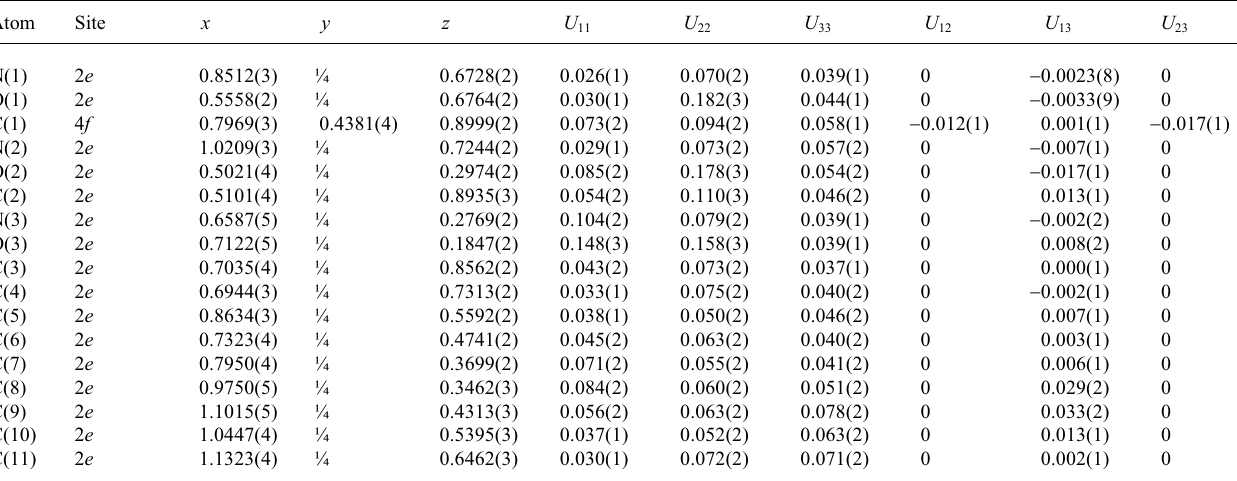
Table 3. Atomic coordinates and displacement parameters (in Å 2 )